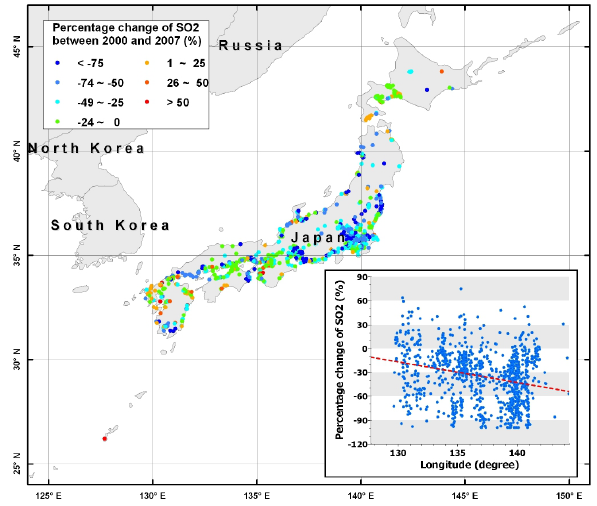
Fig. 9. Percentage change of annual SO 2 concentration at sites of the Japan National Air Monitoring Network between 2000 and 2007 (from database of Japan NIES). The inset plots the percentage change of SO 2 versus site